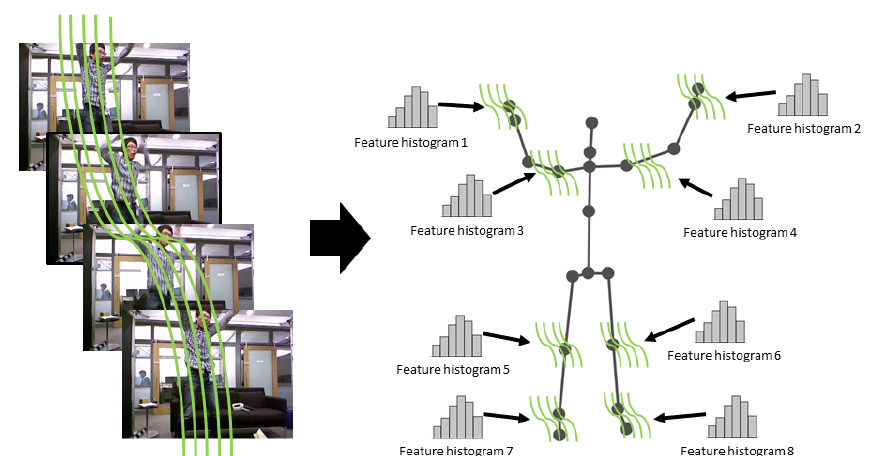
Figure 2. The two stages of Localized Trajectories: Left: clustering motion trajectories around body joints; and Right: local features computation which boosts the discriminative power of the original Dense Trajectories